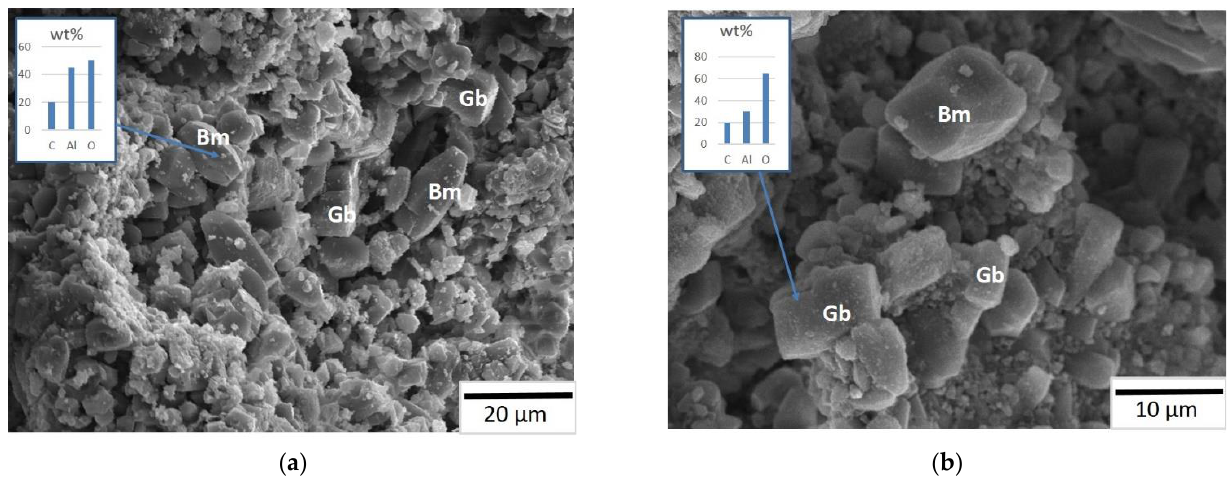
Figure 8. SEM images gibbsite (Gb) and boehmite (Bm): ( a ) barrel-shaped crystals boehmite; ( b ) large well-crystallized boehmite.